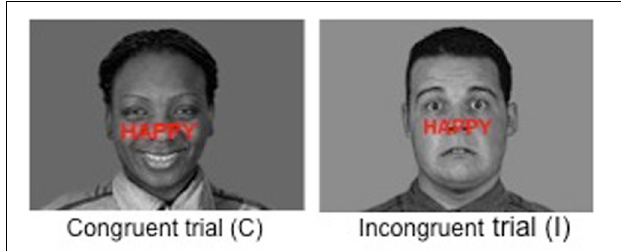
FIGURE 1 | Examples of stimuli used in the modified emotional Stroop